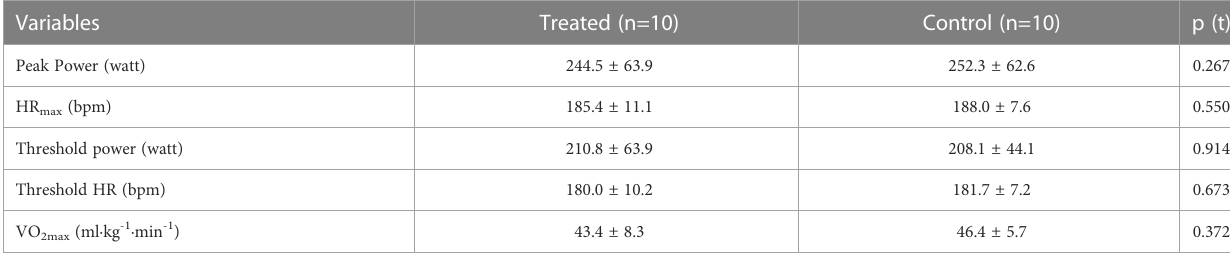
TABLE 2 GXT results (data are expressed as mean ±